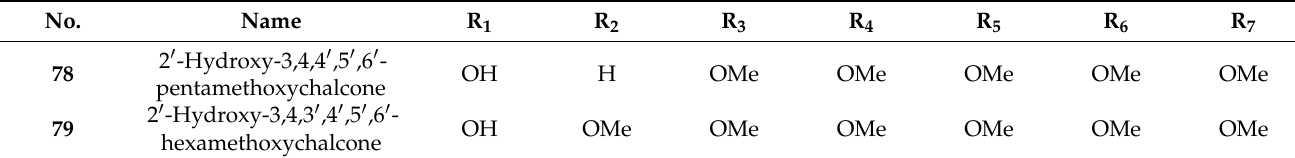
Table 14. Chemical structures of polymethoxychalcones ( 78 – 79 ) occurring in Citrus